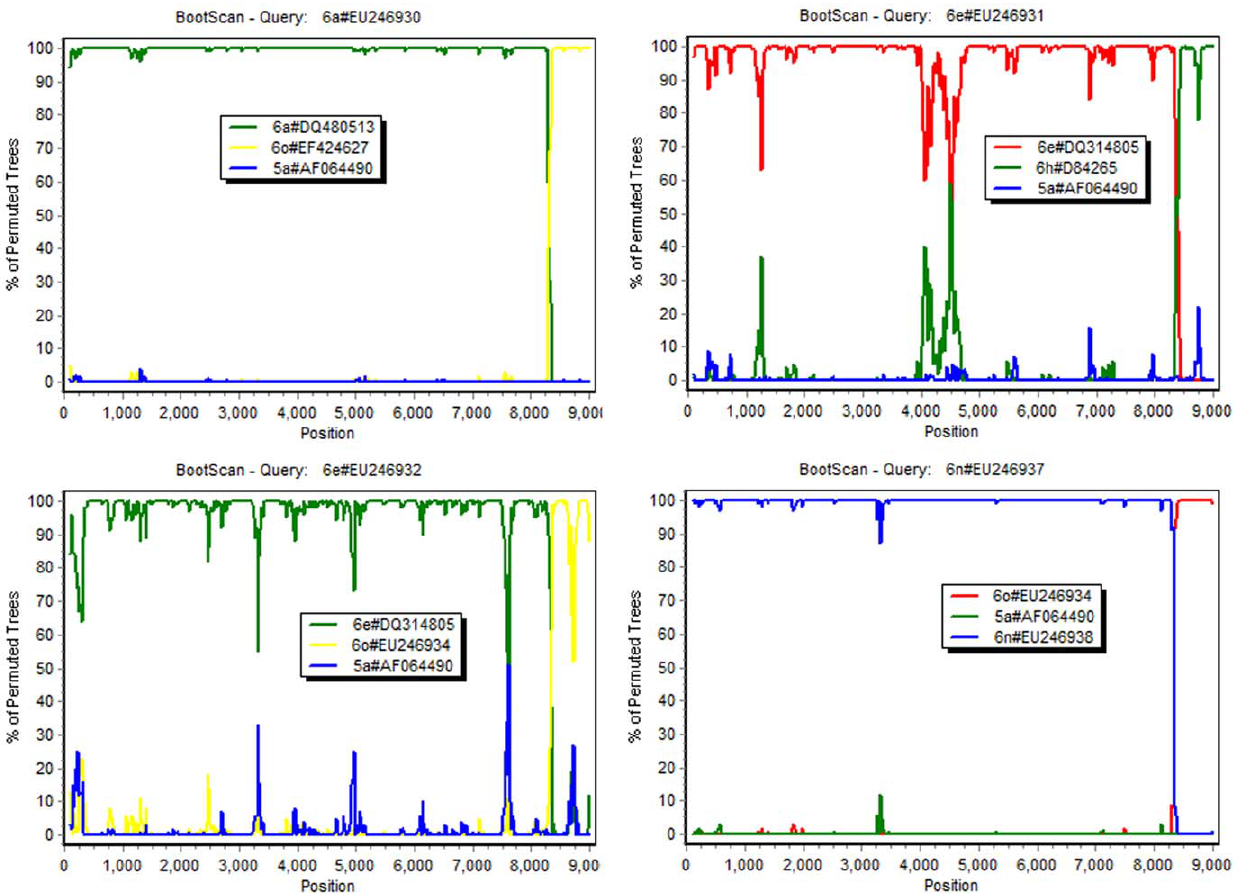
Figure 3. BootScan analysis of the novel recombinants and their possible parents. The coding region for the NS5B protein starts from position 7327 and ends at position 9099 in our alignment. Different colors represent sequences of different subtypes, two of which are the possible parental sequences and one of which (5a # AF06490) serves as an outgroup. doi:10.1371/journal.pone.0041997.g003 PLoS ONE |